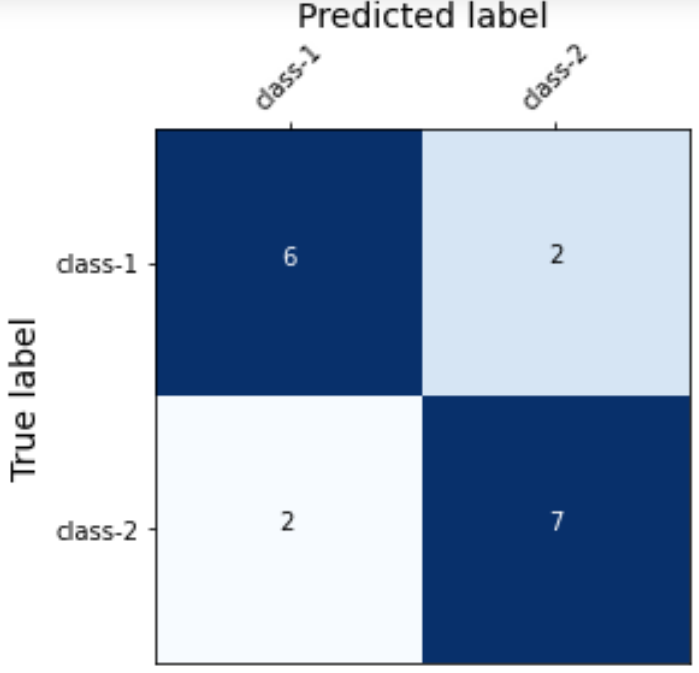
Figure 4. Confusion matrix of uni–bi–tri-gram +